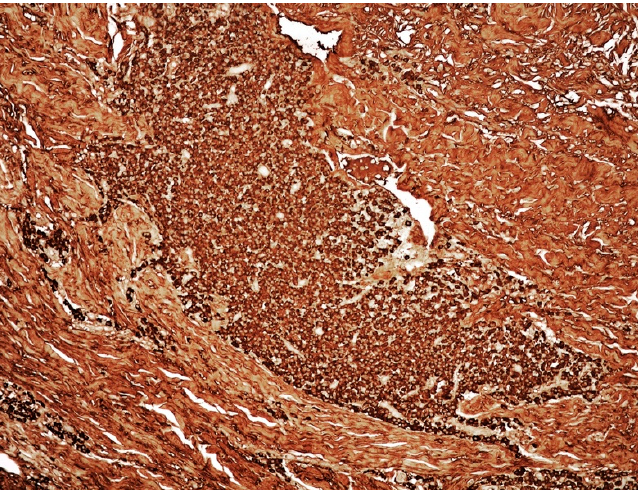
Figure 4. Medium-power view of PCMZL, plasmacytic variant: plasma cells elements monotypic for kappa immunoglobulin light chain (immunostaining, magnification 100×; original image from Prof. S.A.).